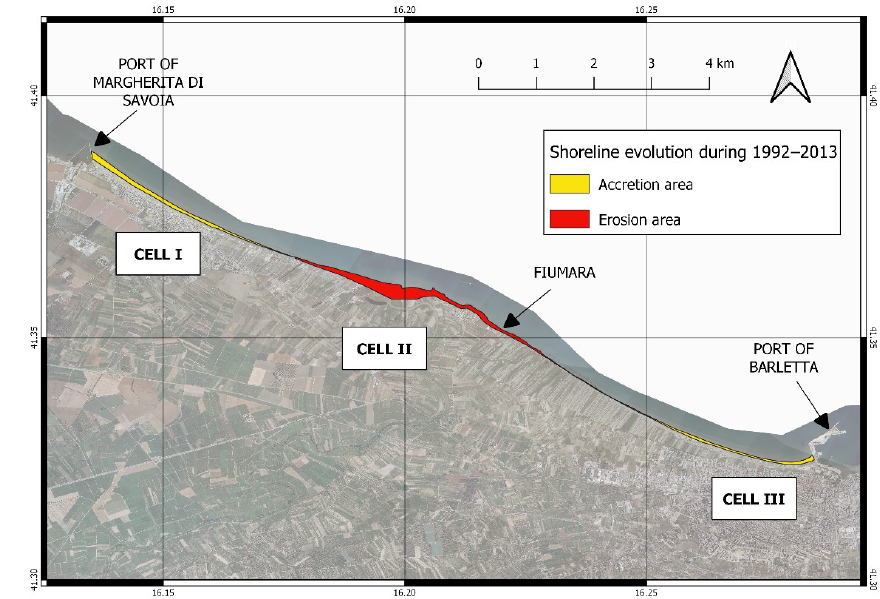
Figure 4. Accumulation and retreat areas in Cell I–Cell III during the overall observation period